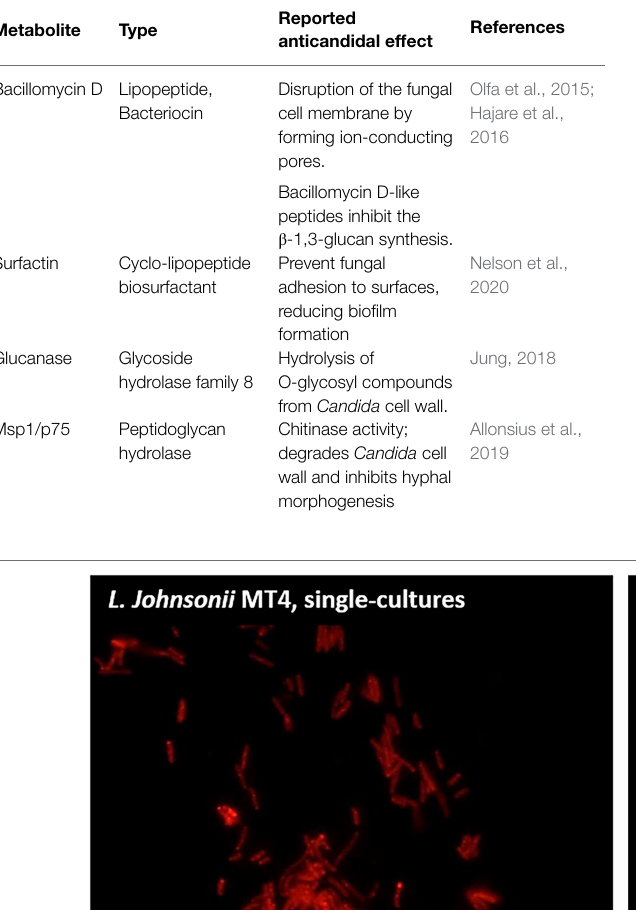
TABLE 1 | Lactobacillus johnsonii strain MT4 possesses genes encoding for metabolites similar to products reported to display anticandidal